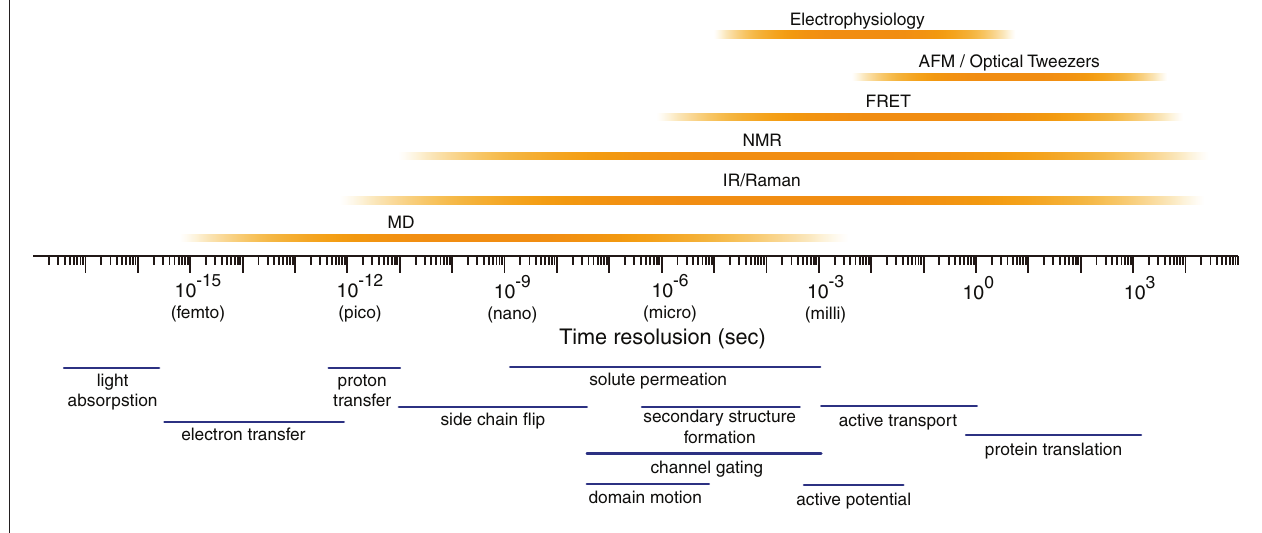
FIGURE 1 | Temporal resolution of various biophysical techniques. The timescales of some fundamental atom- or molecule-scale motions are shown below. AFM, atomic force microscopy; FRET, fluorescence resonance energy transfer; IR, infrared radiation; NMR, nuclear magnetic